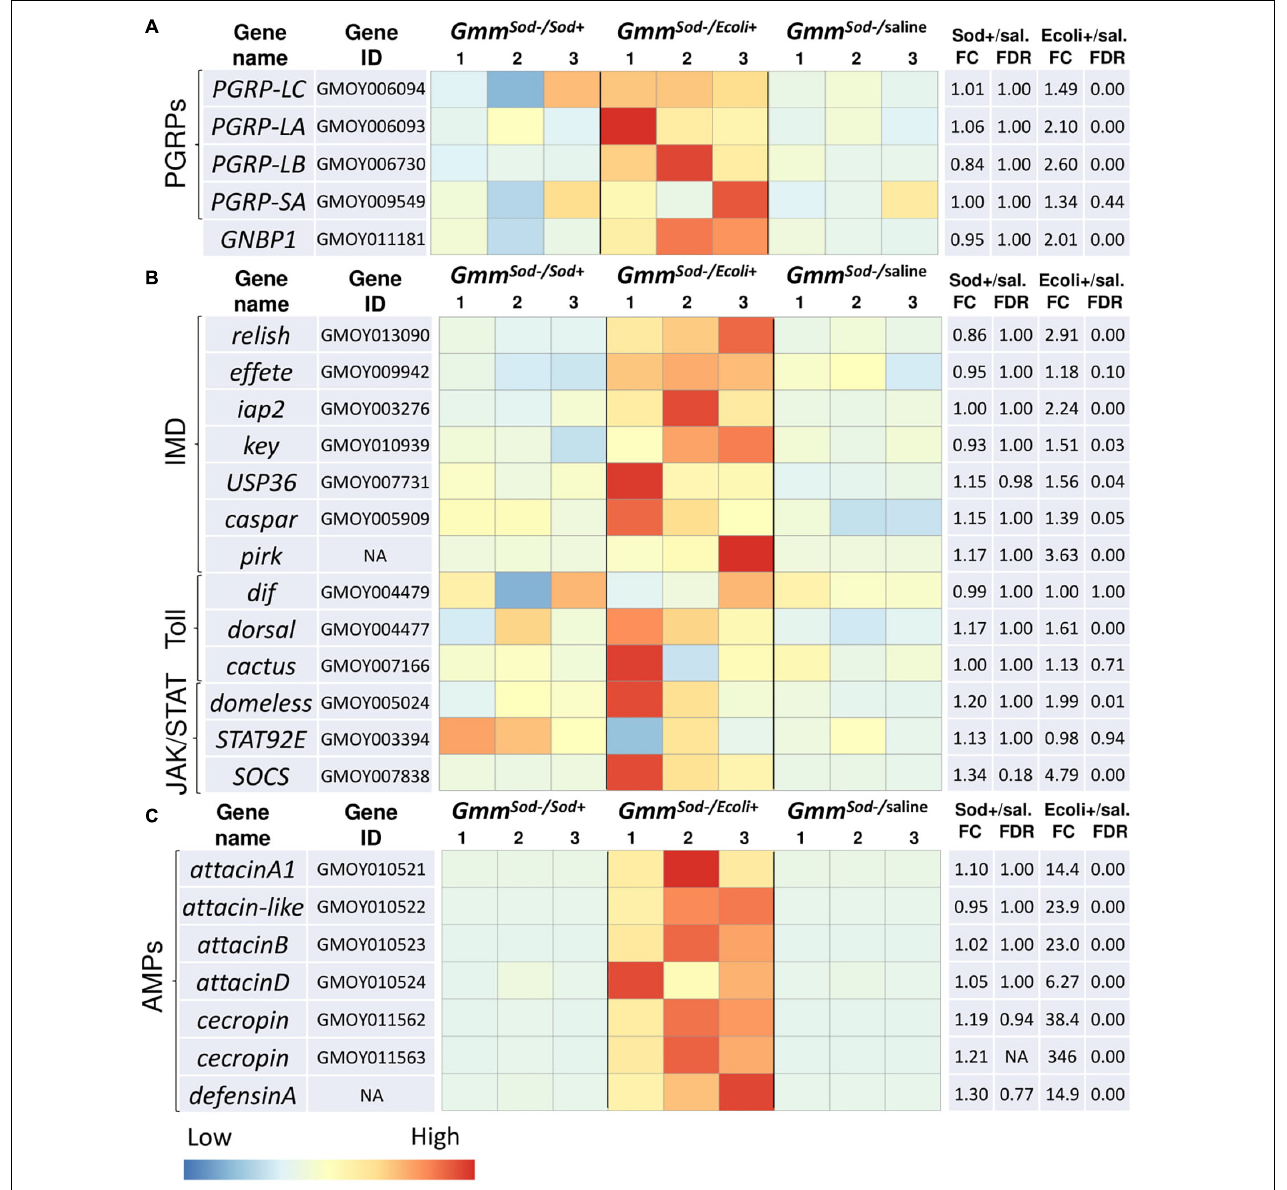
FIGURE 3 | Heat maps showing the transcriptional profiles of innate immunity-related genes obtained by RNA-seq analysis of S. glossinidius -free ( Gmm Sod − ) flies exposed to 10 6 CFU Sodalis glossinidius ( Gmm Sod − / Sod + ) or 10 5 CFU E. coli ( Gmm Sod − / Ecoli + ) and their corresponding injection-control with sterile saline ( Gmm Sod − / saline ). Bacterial exposure was performed on day 8 post-eclosion via intrathoracic microinjection as well as per os and total RNA was extracted after 48 h. Genes encoding (A) immune-related recognition proteins, (B) components of the three major immune signaling pathways; the immune deficiency (Imd)-, Toll-, and JAK/STAT-pathway, and (C) antimicrobial peptides (AMPs). Heat maps were obtained by plotting the normalized read counts scaled by row. Colors indicate the z -scores ranging from -1 (blue: low expression) to 1 (red: high expression). The biological replicates are indicated as numbers above the columns. Significantly differentially expressed genes (DEG) were defined by a p -value < 0.05 and a false discovery rate (FDR; Benjamini-Hochberg adjusted p -value) < 10%. Dif, dorsal-related immunity factor; Ecoli+, Gmm Sod − / Ecoli + ; FC, fold change; GNBP1, gram-negative binding protein 1; iap2, inhibitor of apoptosis 2; key, kenny; NA, not applicable; PGRP, peptidoglycan recognition protein; sal., sterile saline-injected flies; SOCS, suppressor of cytokine signaling; Sod+, Gmm Sod − / Sod + ; STAT92E, signal transducer and activator of transcription 92E; USP36, ubiquitin-proteasome related protein